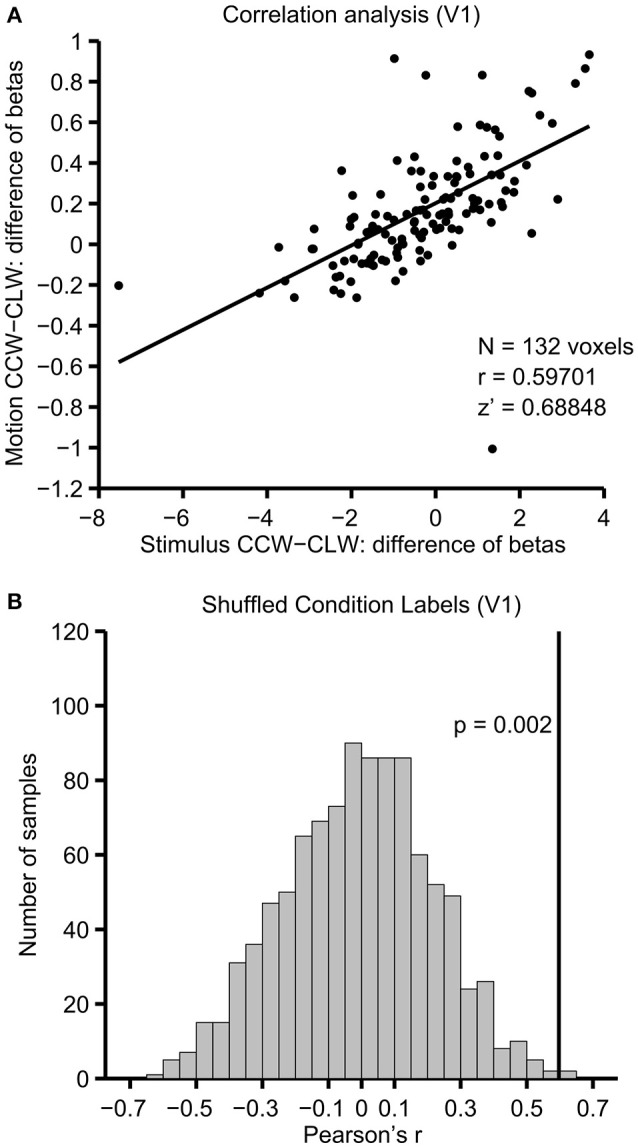
Correlation and permutation testing. Illustrated for V1 in a single example participant. (A) The difference of beta coefficients between motion conditions (y-axis) and physical stimulus shift conditions (x-axis) for each of the 132 voxels that survived the voxel selection procedure in V1 of this participant. (B) Correlations resulting from repeating this analysis 1,000 times, while shuffling the labels between CLW-M and CCW-M. The unshuffled correlation, illustrated with a solid line, was higher than all but 2 of the shuffled correlations, indicating that the correlation is stronger than what would be expected given the null hypothesis that there is no information shared between the motion and stimulus shift contrasts.